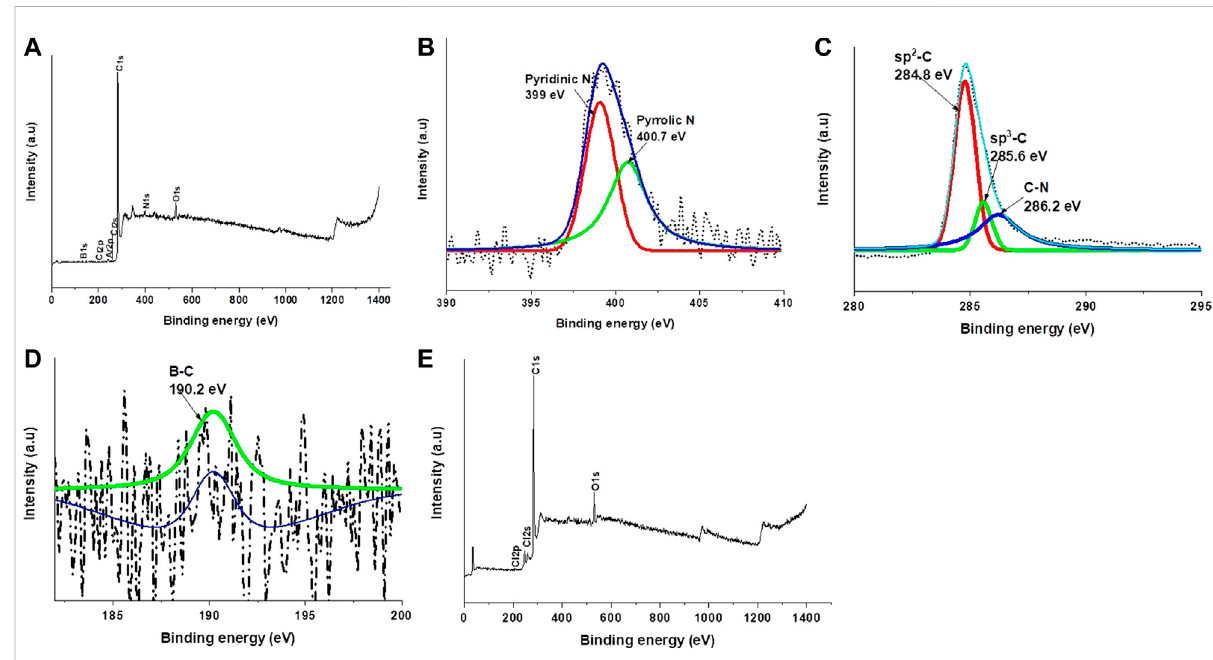
FIGURE 6 Deconvoluted high-resolution XPS spectra of C1s (A), N1s (B), and B1s (C) of CNMs generated from dichlorobenzene and triphenylborane as chlorine and boron sources,